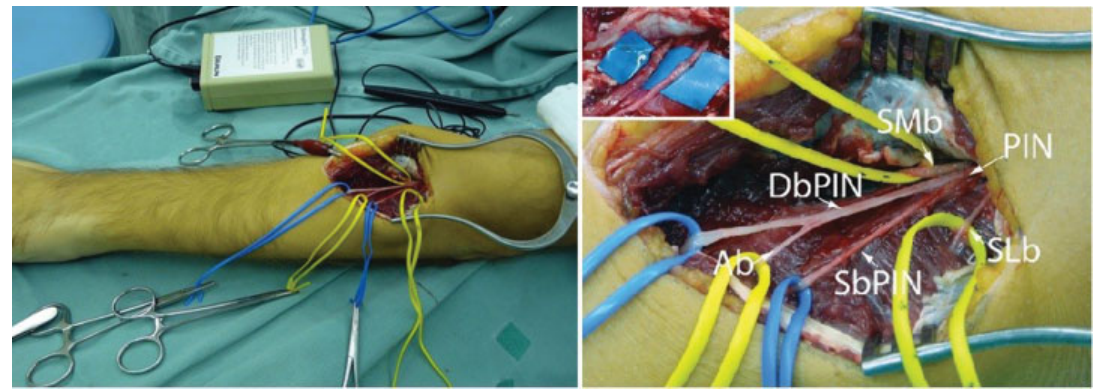
Fig. 2 Photograph of the incision used to transfer supinator branches to the posterior interosseous nerve in the left upper limb. Medial (SMb) and lateral (SLb) branches, and the posterior interosseous nerve (PIN). The particularity in this patient was a proximal division of the PIN into its super fi cial (SbPIN) anddeep (DbPIN) branches. The super fi cial posteriorinterosseousinnervatesthe extensordigitorum communis, the extensor digit quinti, and the extensor carpi ulnaris. The deep branch of the posterior interosseous nerve innervates the abductor pollicis longus (Ab), the extensor pollicis longus, and the extensor indicis proprius. 18